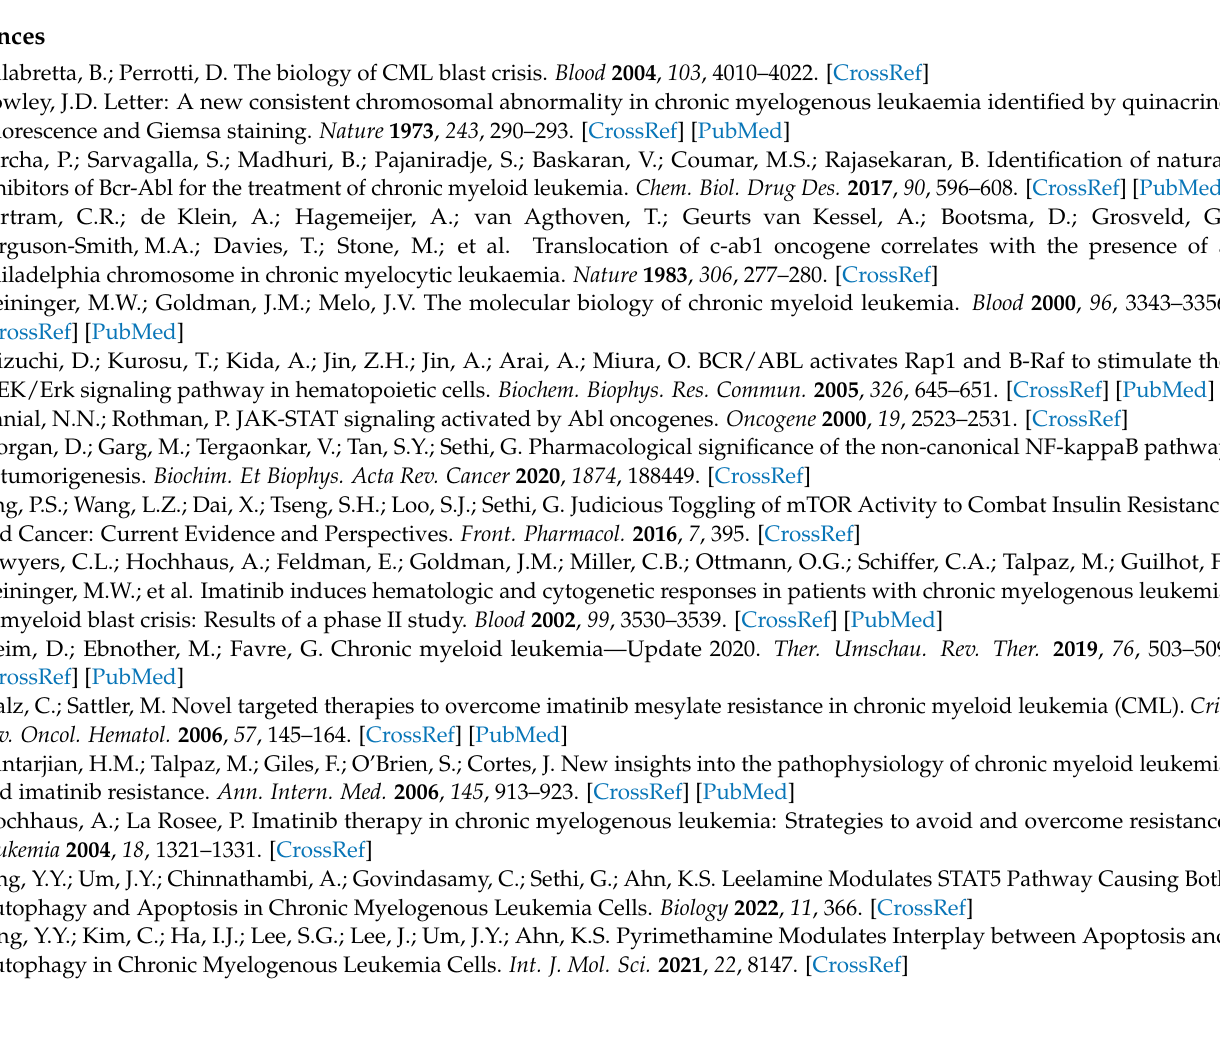
Figure S2: Western blot data for Figure 2A; Figure S3: Western blot data for Figure 2B; Figure S4: Western blot data for Figure 2D; Figure S5: Western blot data for Figure 3D; Figure S6: Western blot data for Figure 4A; Figures S7–S10: Western blot data for Figure 4B; Figure S11: Western blot data for Figure 4C; Figures S12 and S13: Full Western blot images for Figure 1C; Figures S14 and S15: Full Western blot images for Figure 2A; Figures S16 and S17: Full Western blot images for Figure 2B; Figures S18 and S19: Full Western blot images for Figure 2D; Figure S20: Full Western blot images for Figure 3D; Figures S21–S23: Full Western blot images for Figure 4A; Figures S24–S29: Full Western blot images for Figure 4B; Figures S30 and S31: full Western blot images for Figure